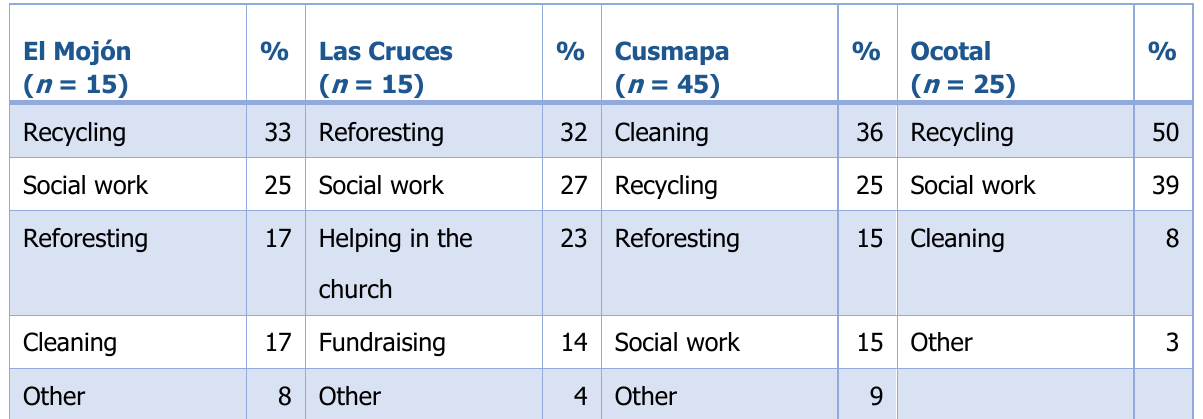
Table 3. Percentage of Responses by Each Community for the Statement: “We could help our community